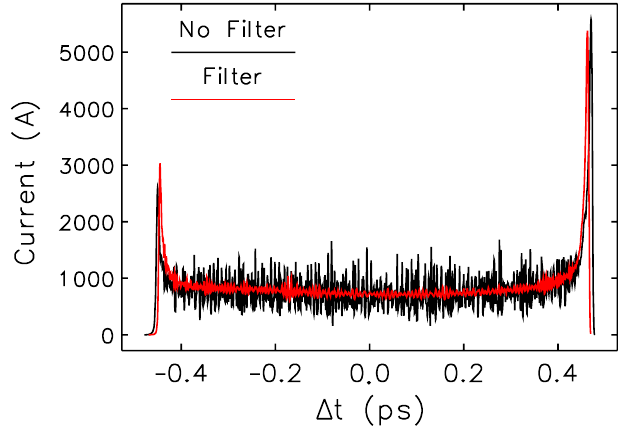
FIG. 6. (Color) Final longitudinal density for FERMI, showing the effect of the low-pass filter when 20 (cid:1) 10 6 particles are